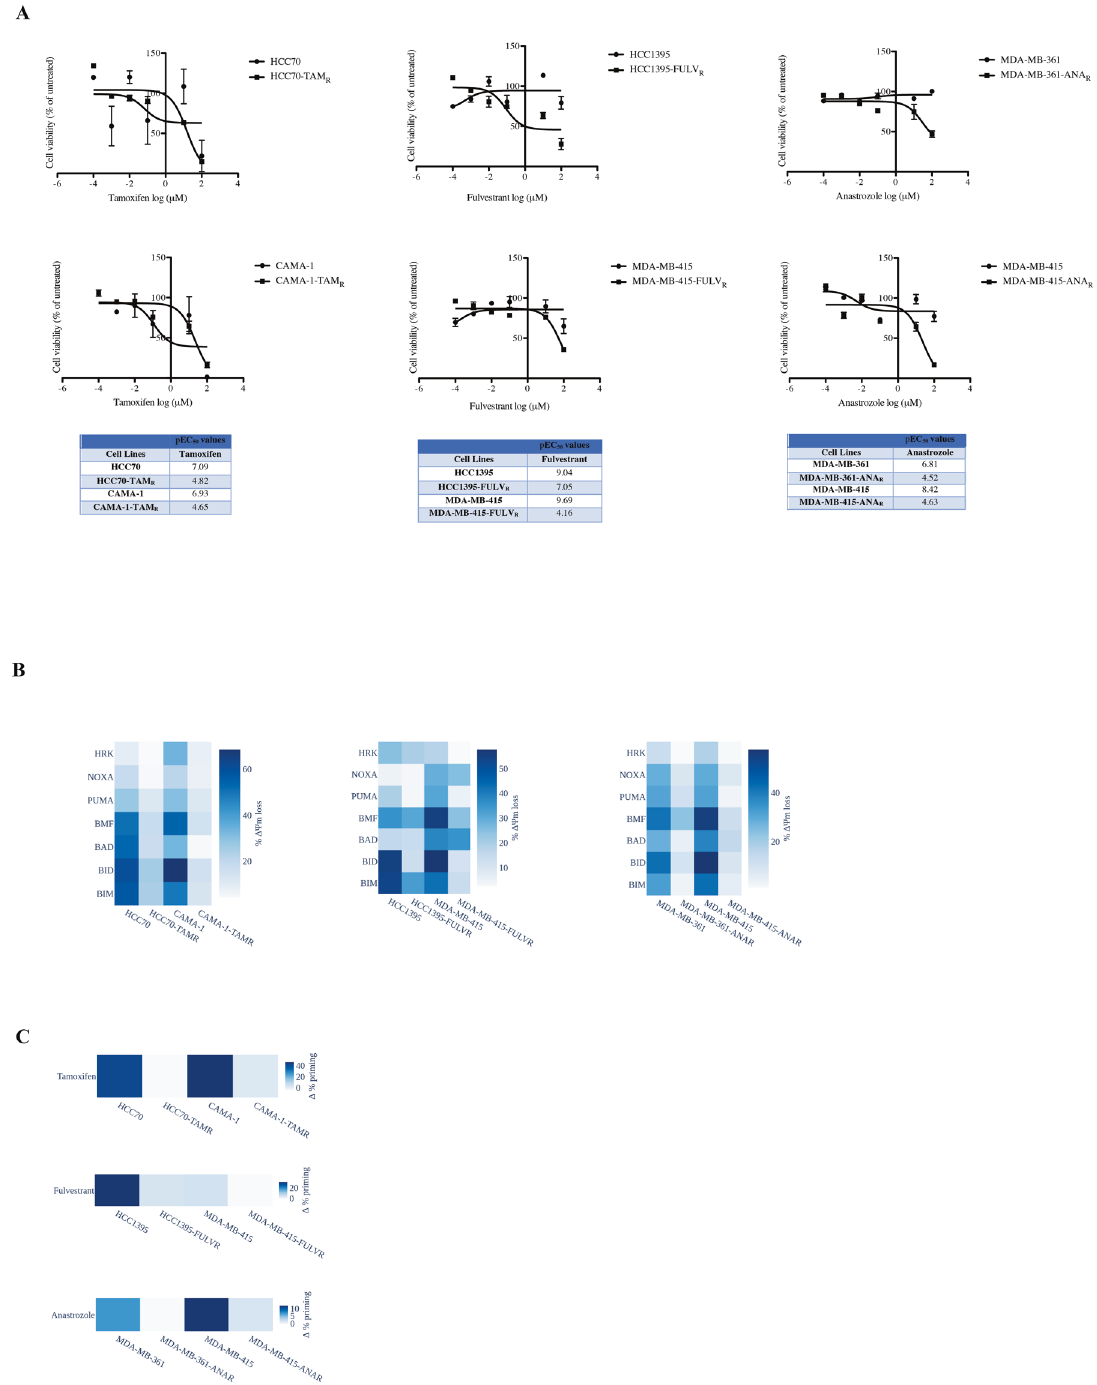
Fig. 3 BH3 pro fi ling and dBH3 pro fi ling assays predict the development of acquired resistance to endocrine therapy agents. A HCC70, HCC70-TAM R , CAMA-1, CAMA-1-TAMR, HCC1395, HCC1395-FULV R , MDA-MB-415, MDA-MB-415-FULV R , MDA-MB-361, MDA-MB-361-ANA R , MDA-MB-415, and MDA-MB-415-ANA R cells were treated with indicated concentrations of tamoxifen, fulvestrant, and anastrozole for 48 h, and cell viability was evaluated by CellTiter-Glo assay (mean ± SEM, n = 3). EC 50 values of parental and resistant cells were determined by nonlinear regression analysis and pEC 50 values were shown in the tables. Heat-map of ( C ) BH3 pro fi les (peptides with 10 µM concentrations) and ( D ) dBH3 pro fi les (BIM with 10 µM concentration) of parental and resistant breast cancer fulvestrant Δ % priming in ER- α ( + )/ER- β ( + ) breast cancer cells (Fig. keeping with the superior competency of dBH3 pro fi ling for S7E), although we did not fi nd any signi fi cant association between predicting response to endocrine therapy in breast cancer cells, ER- β mitochondrial localization and Δ % priming (Fig. S7F). When we we also investigated whether ER- α and ER- β mitochondrial analyzed the data for all 20 cell lines, we identi fi ed correlation localization correlate with dBH3 priming status. We found that between ER- β mitochondrial localization and tamoxifen Δ % priming increased ER- α mitochondrial localization correlates negatively with